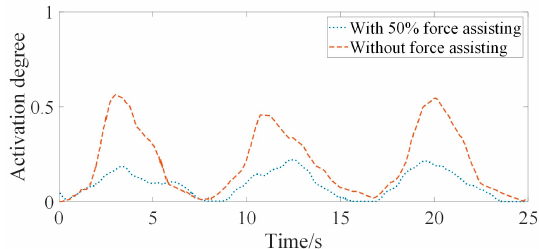
Figure 19. Comparison of activation of surface EMG signal of biceps brachii